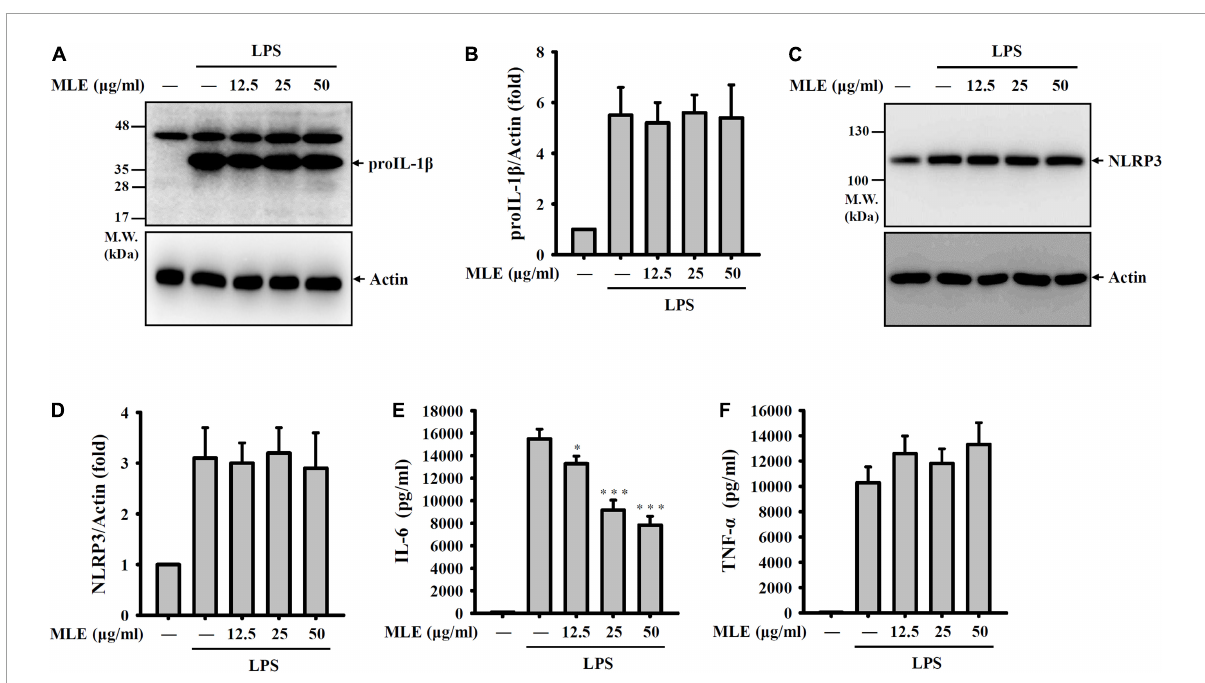
FIGURE3 MLE did not inhibit the priming signals of the NLRP3 inflammasome. (A–F) J774A.1 macrophages were incubated with MEL for 0.5 h before LPS stimulation for an additional 6 h. (A) The levels of proIL-1 β in the cell lysates were analyzed by western blot. (B) The column diagram represents the fold change of proIL-1 β in (A) compared with the control group normalized to actin analyzed by ImageJ. (C) The levels of NLRP3 in the cell lysates were analyzed by western blot. (D) The column diagram represents the fold change of NLRP3 in (C) compared with the control group normalized to actin analyzed by ImageJ. The levels of IL-6 (E) and TNF- α (F) in the supernatants were analyzed by ELISA. The western blot images are representative of three different experiments. The ELISA data are expressed as the mean ± SD of three separate experiments. * p < 0.05 and *** p < 0.001 compared to the LPS group.